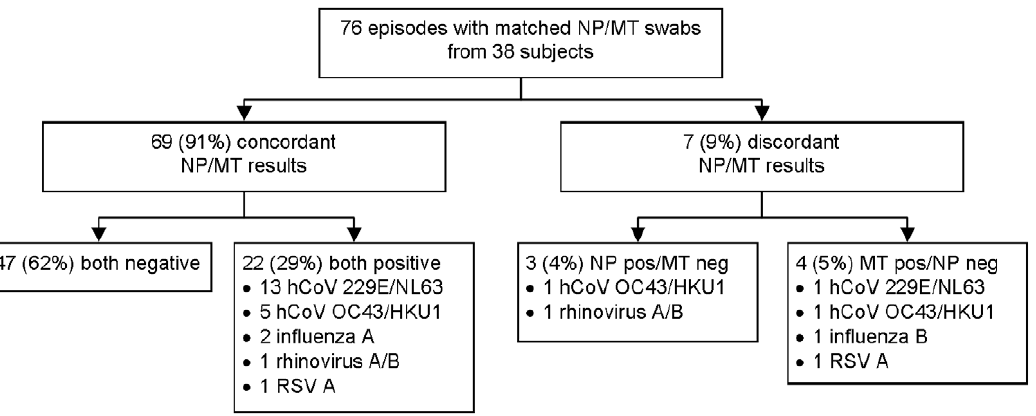
Figure 1. Results from matched nurse-collected nasopharyngeal and self-collected mid-turbinate swabs from adults with acute respiratory illness. Foot note: hCoV: human coronavirus, MT: mid-turbinate, neg: negative, NP: nasopharyngeal, pos: positive, RSV: respiratory syncytial virus.